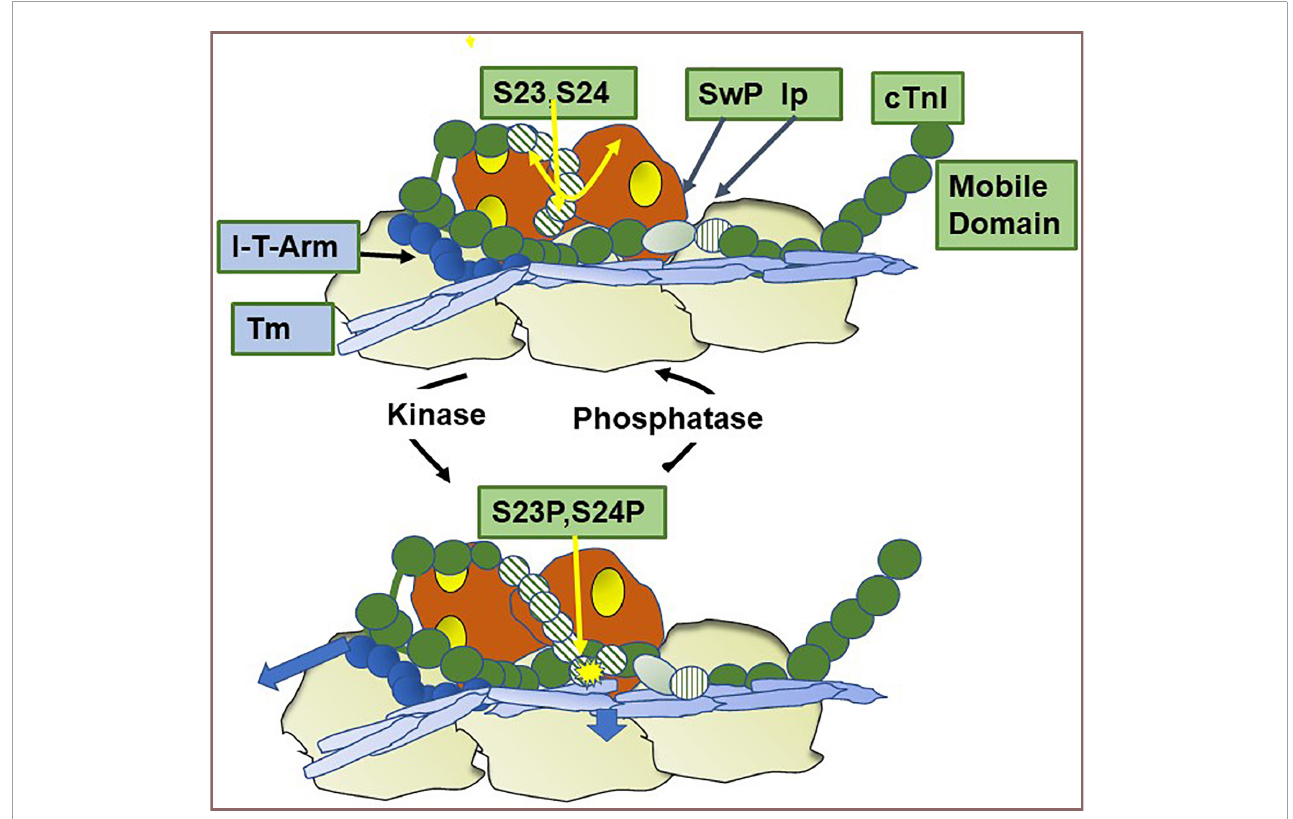
FIGURE4 Modulation of thin filament activation by cTnI N-terminal phosphorylation. Shown is a cartoon based on recent studies (7) of a region of a Ca-activated thin filament showing the effect of phosphorylation of Ser 23 and Ser 24 in the unique N-terminal peptide of cardiac troponin I (cTnI). In the dephosphorylated state the N-terminal peptide is mobile as indicated by the double yellow arrow. Also shown are the positions of the cardiac troponin I switch peptide (Sw), inhibitory peptide (Ip), and troponin I-troponin T interaction (I-T arm) described in Figure 1 . Phosphorylation induces an interaction of the N-terminal peptide with actin-tropomyosin and as shown by the arrow in the figure moves tropomyosin (Tm) to a position favoring the off state of the thin filament, thereby decreasing myofilament response to Ca 2 + and promoting relaxation. Cys residues reported to be S-glutathionylated (42) are located in the region of the I-T arm (Cys-80) and in a helix N-terminal to the Ip (Cys 97). See text for further